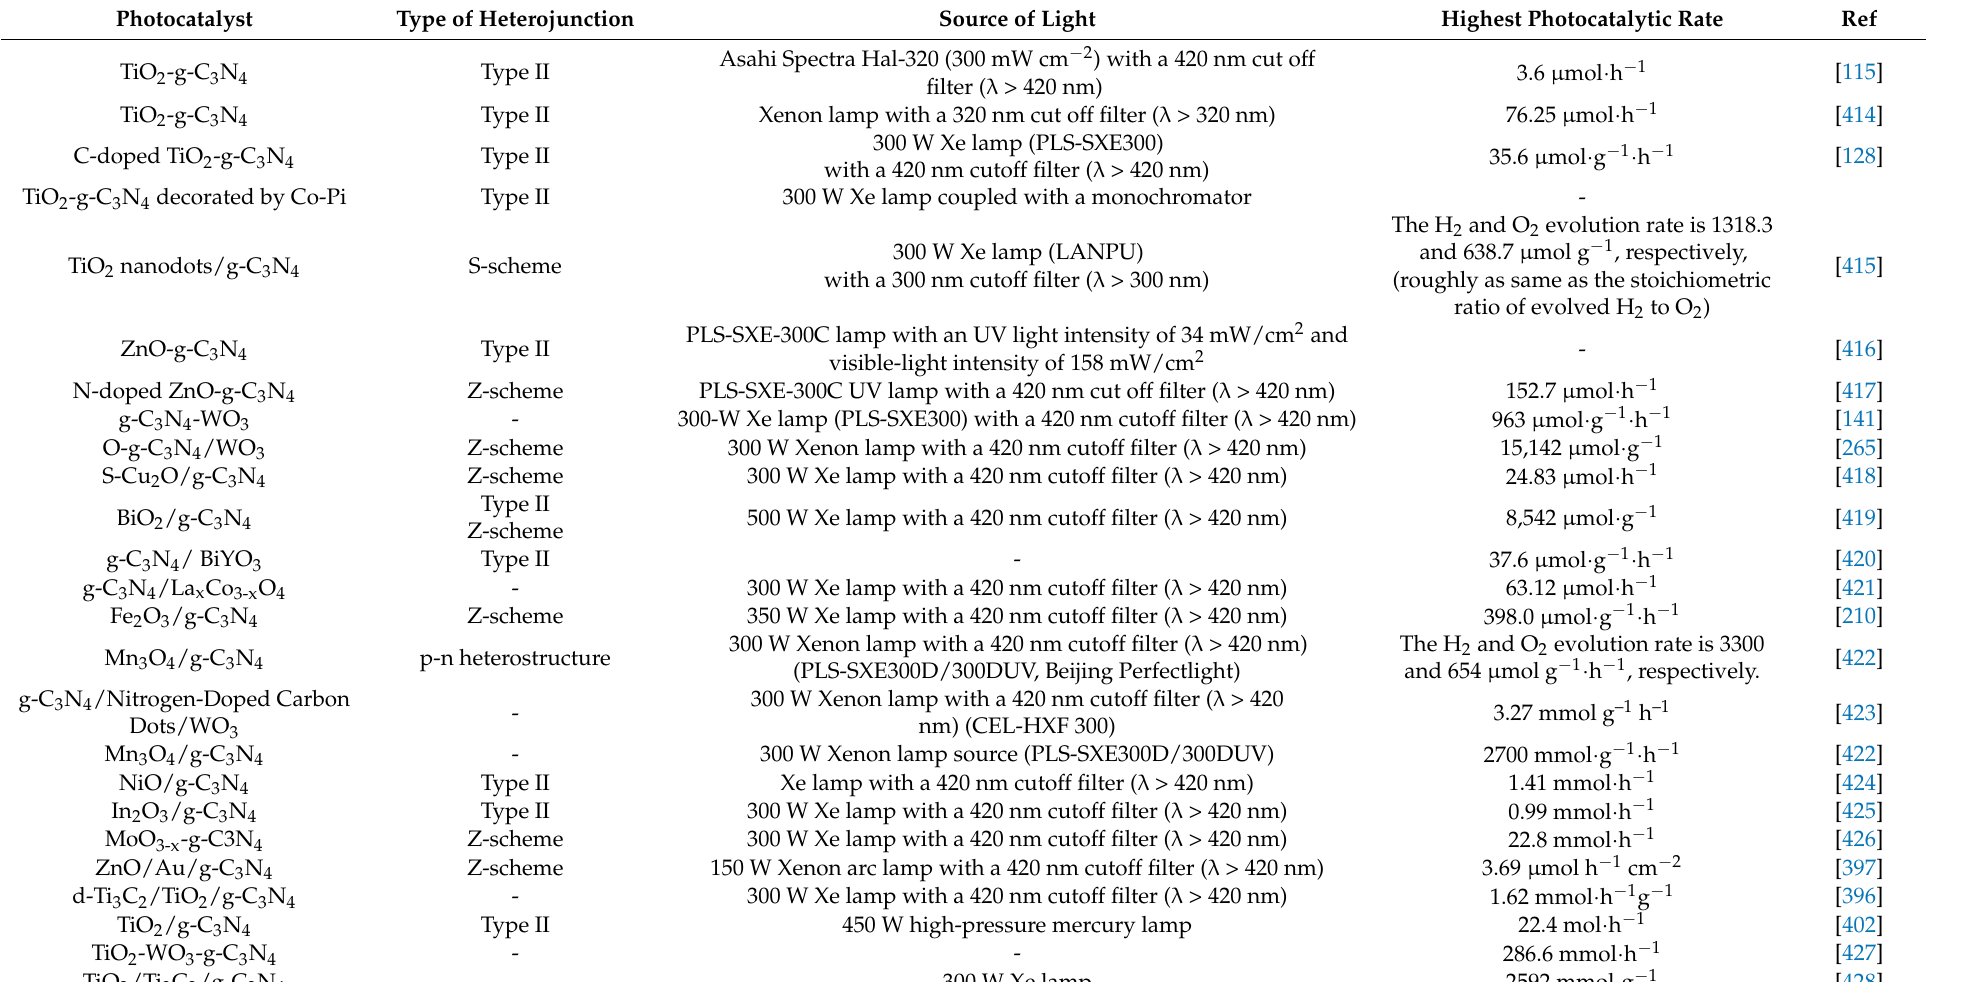
Table 2. A list of selected works on g-C 3 N 4 –metal oxide-based photocatalytic water